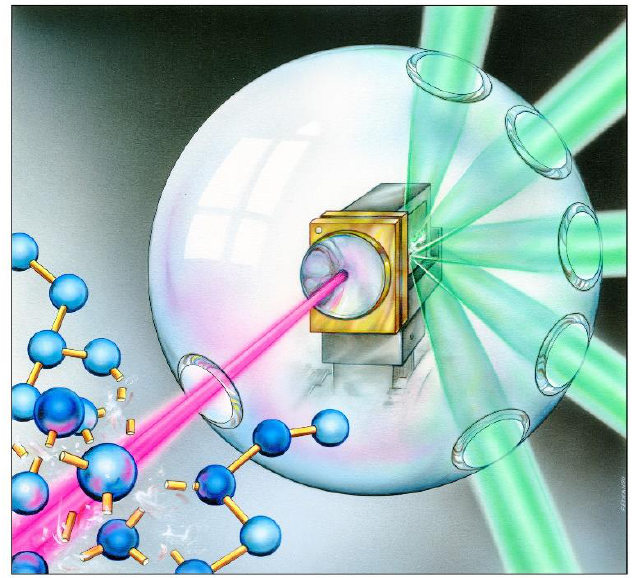
Figure 1. Cover of the January 1987 issue of the famous French Journal La Recherche showing an artist’s view on how the laser-produced plasma-based soft-X-ray laser beam (false color: violet) decomposes a molecule [10]. The artist/graphic designer: © Fernando da Cunha (reproduced with artist’s permission).